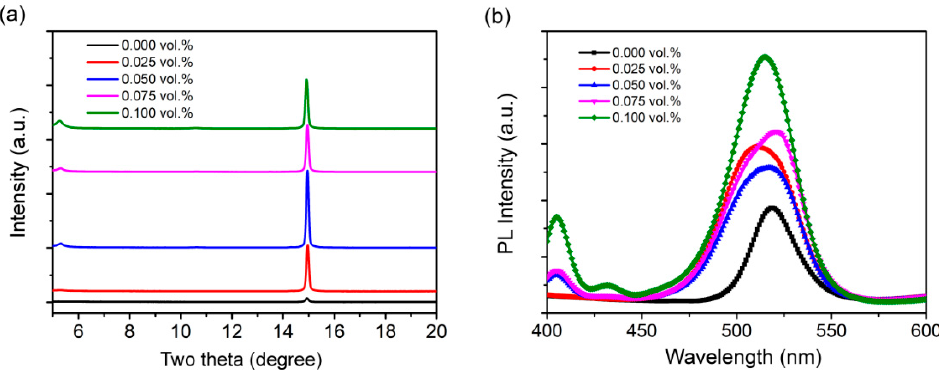
Figure 5. The XRD patterns ( a ) and PL spectra ( b ) of CH 3 NH 3 PbBr 3 films with different concentra- tions of PMA.